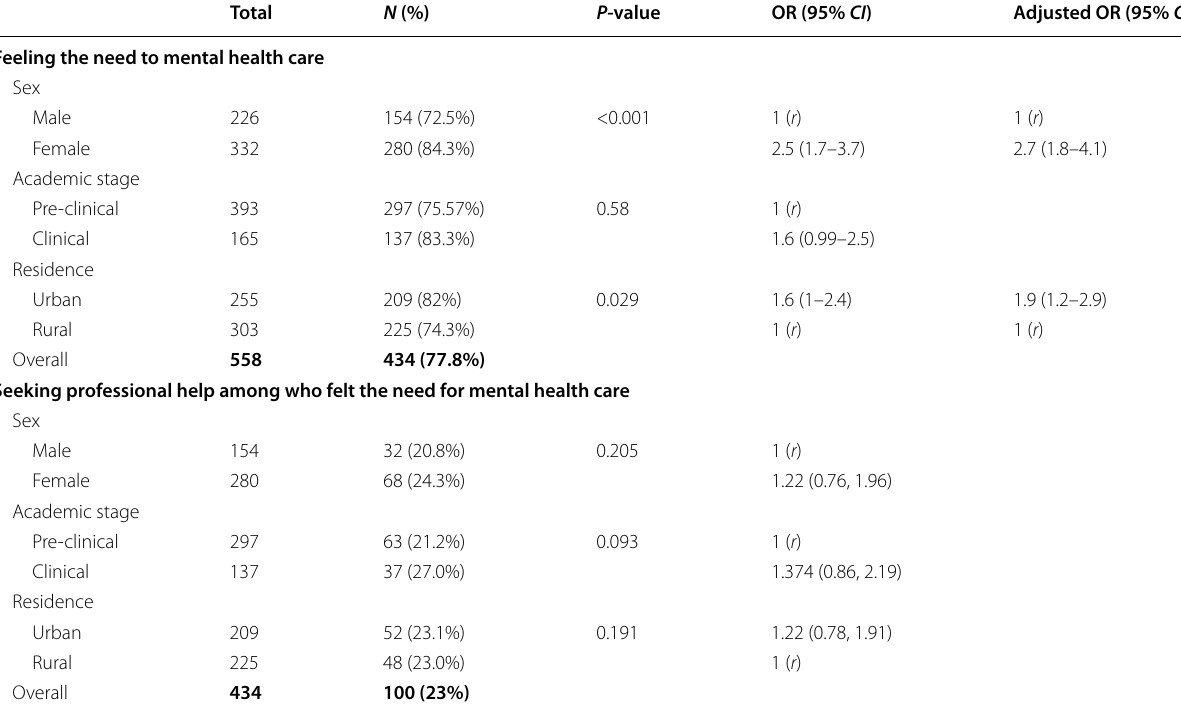
Table 1 Independent predictors for feeling the need to seek mental healthcare and actual seeking of professional care Total N (%) P -value